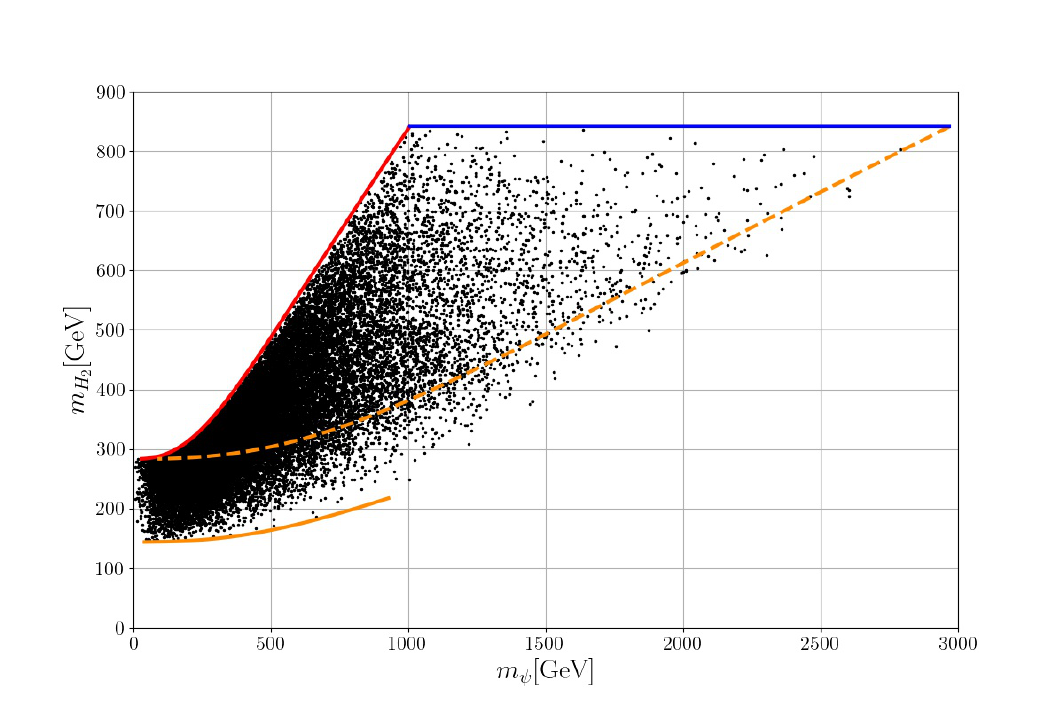
Figure 6: Correlation between the new physics scales m ψ and m following H 2 from Eqs. (26) and (27) for a set of 8 × 10 4 random combinations of couplings ∈ [ 0.1,1.5 ] and fixed λ = 0.13. The blue line indicates the upper limit on y , λ , λ φ φ S S = 1.5 and λ = 0.1, while the red envelope shows the m which is achieved for λ φ S H 2 S = 1.5 and λ behavior for y = 1.5, λ φ S varying between 0.1 to 1.5. The boundary S to lower values of m is obtained as a superposition of curves with varying λ and H 2 S λ = 0.1. We show two of this curves for λ = 0.1 (solid orange) and φ S with fixed y S λ = 1.5 (dashed S